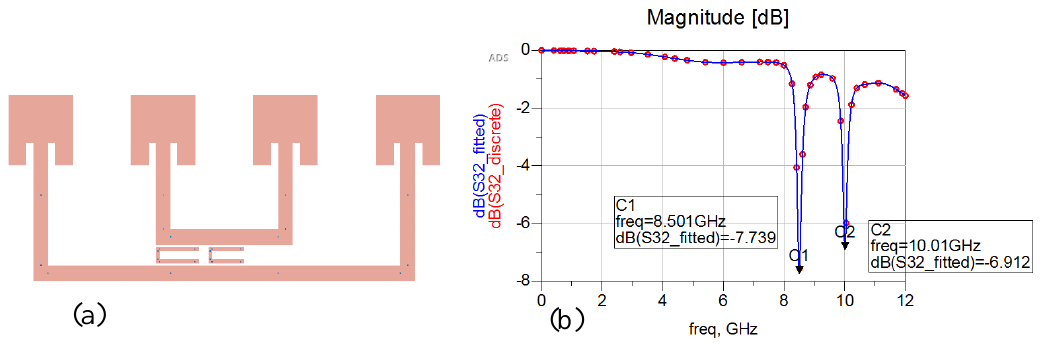
Figure 13. ( a ) Two-bit chipless linear Van Atta array composed of four elements with two C resonators. ( b ) Simulated backscattered response in the X band (8GHz–12GHz).